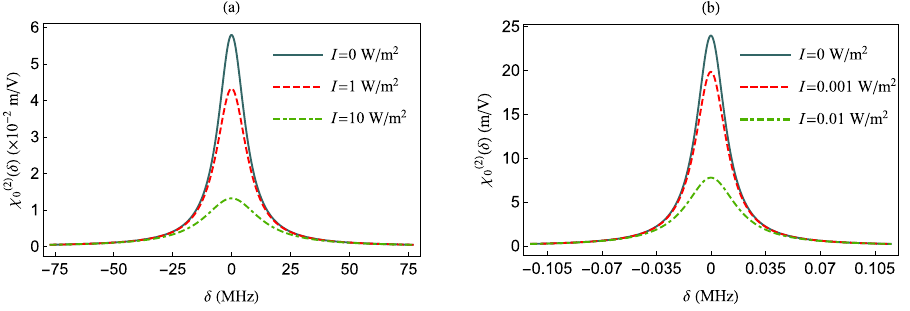
( 2 ) Figure 4. The χ as function of δ for various intensities in absence of the MNP and γ d = 0. The QS 0 transition dipole moment is along the z -axis ( a ) and along the x -axis ( b ).